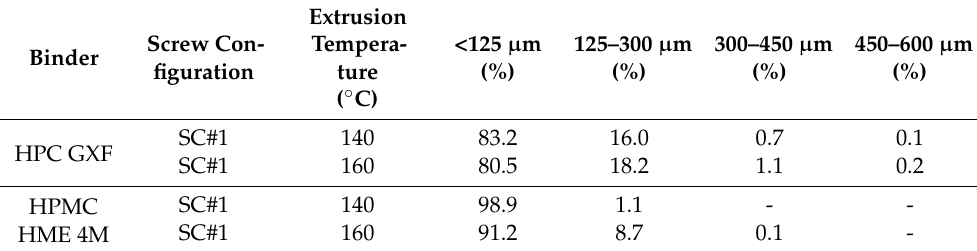
Table 3. Particle size distribution of granules obtained after milling melt-granulated samples of metformin HCl and polymeric binder.